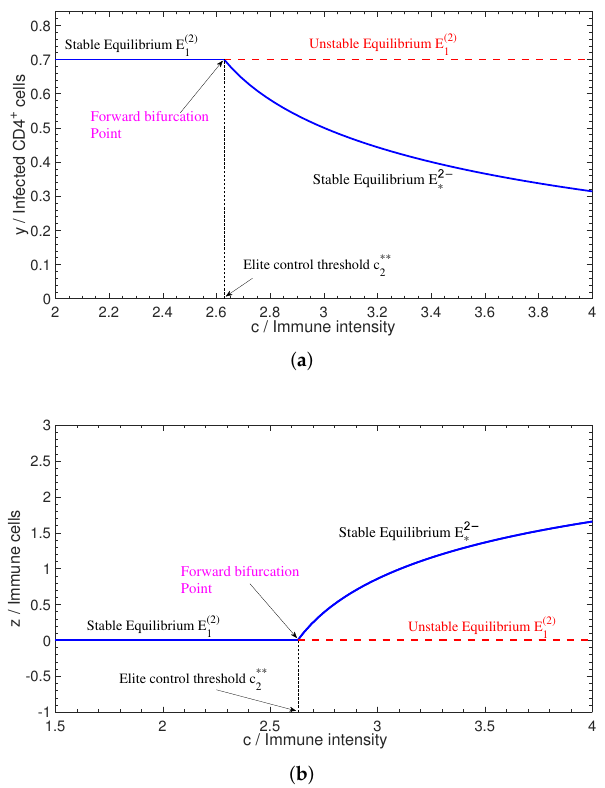
Figure 4. Bifurcation diagrams of system (2) where the vertical axis represents Infected CD4 + T cells (see ( a )) and Immune cells (see ( b )). The parameter values are listed in Table 4 and K = 1.4 cells/ µ L. The solid line represents stable equilibria, and the dotted line represents unstable equilibria. The elite ≈ control threshold c ∗∗ 2